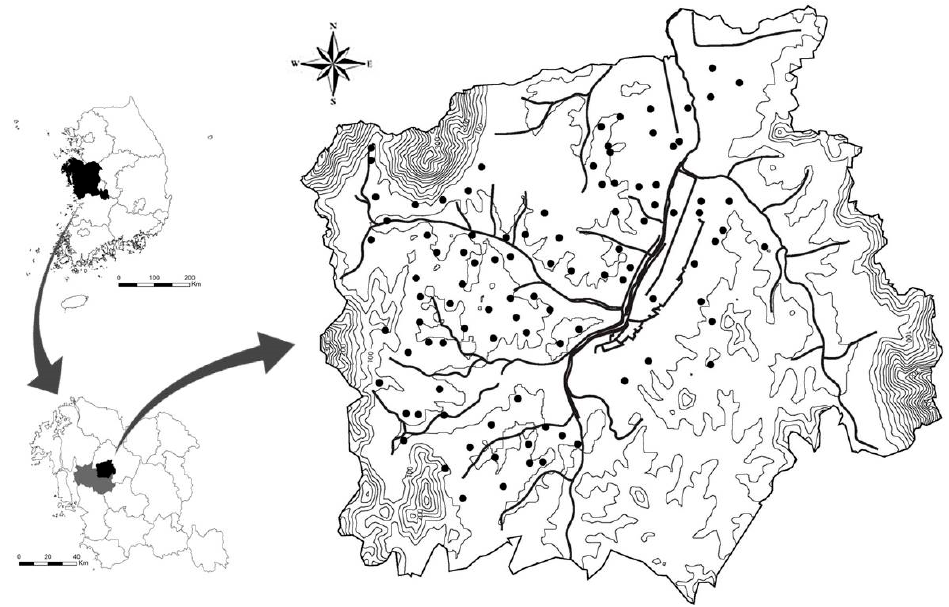
Figure 1. Contour map of elevation of the study area. Solid circles in the map represent locations of the wells where samples were collected. wells where samples were